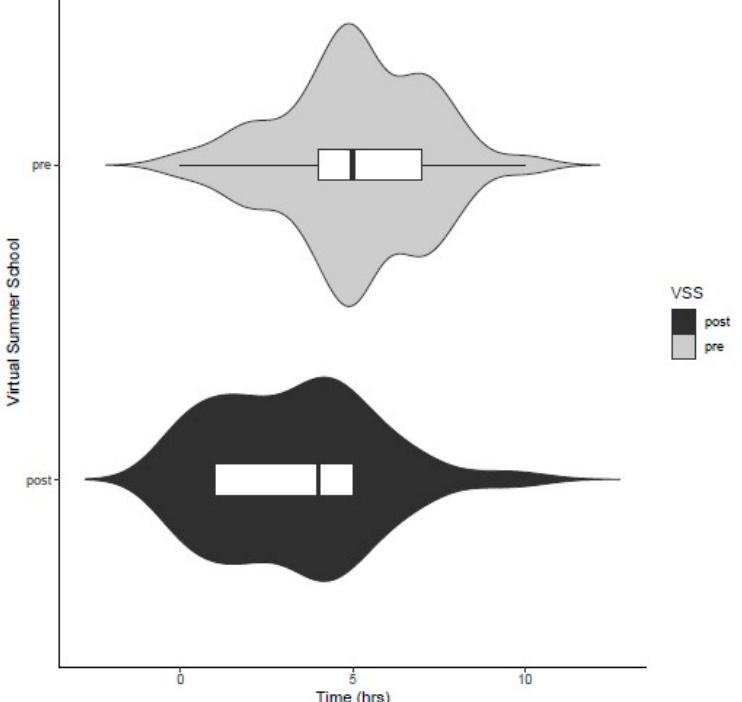
Figure 4. Violin plot of time spent together as a family (in hours per day) before and during the virtual summer school.